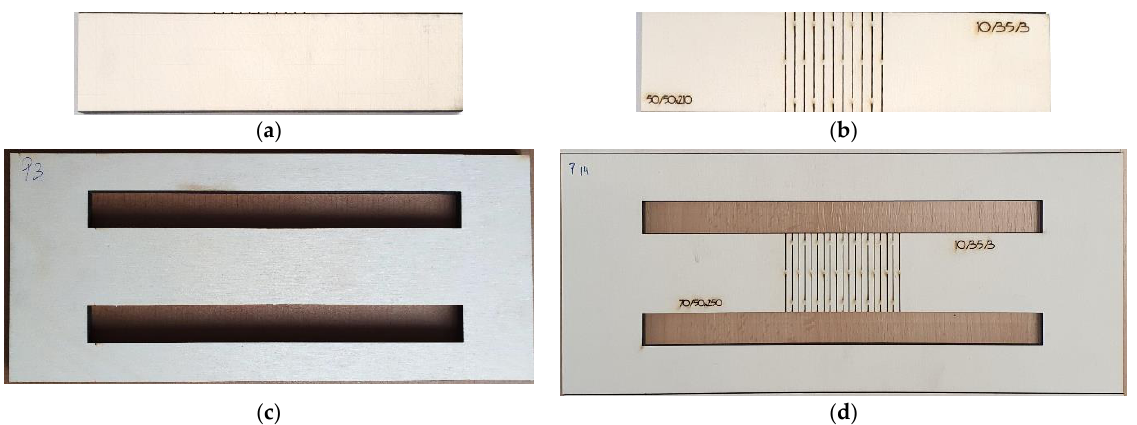
Figure 1. Four types of samples, tested in bending: ( a ) standard; ( b ) simple flexible; ( c ) framed rigid; ( d ) framed flexible.